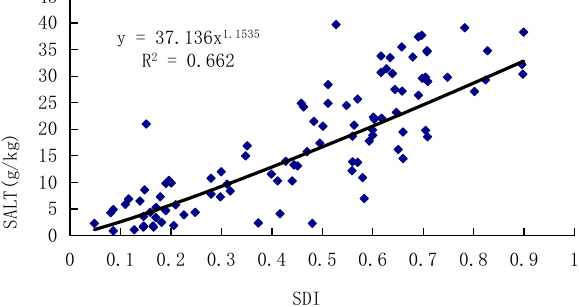
Figure 3. Analysis of correlation between SDI of Operational Land Imager (OLI) image and measured salt content.